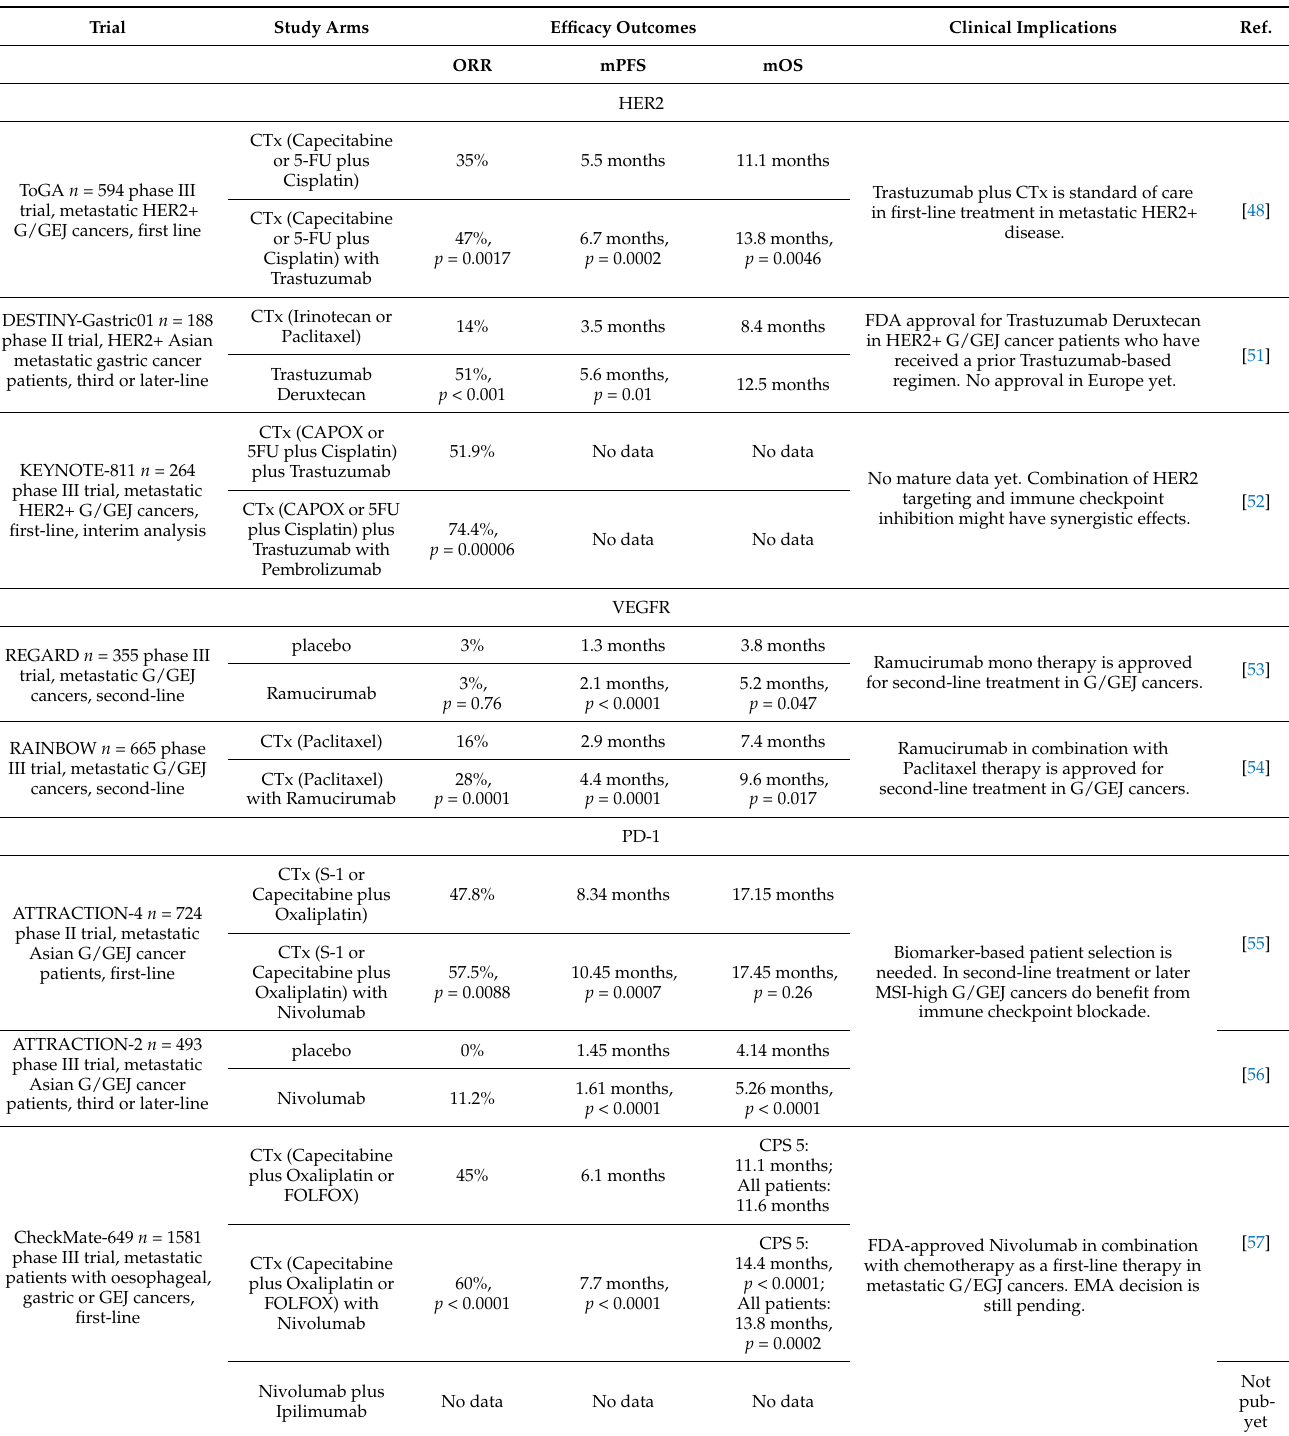
Clinical Implications